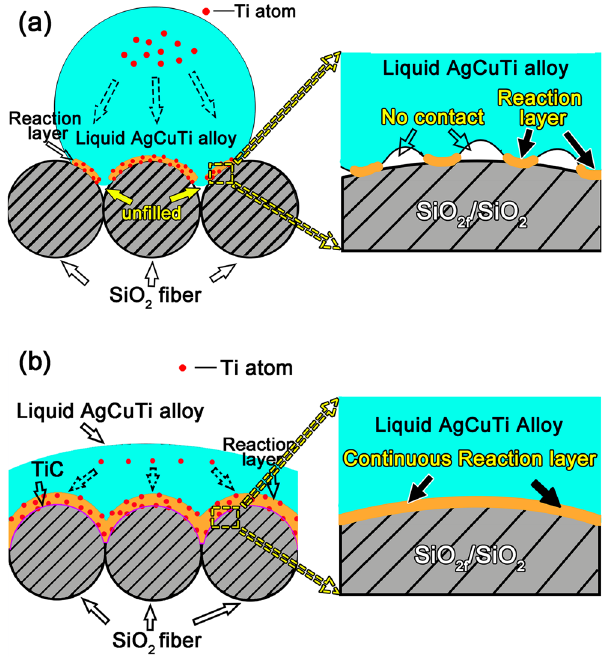
Figure 8. Illustration of the wetting of a SiO 2f /SiO 2 composite by AgCuTi liquid alloy at 850 °C for 10 min: ( a ) without VFG decoration and ( b ) with VFG